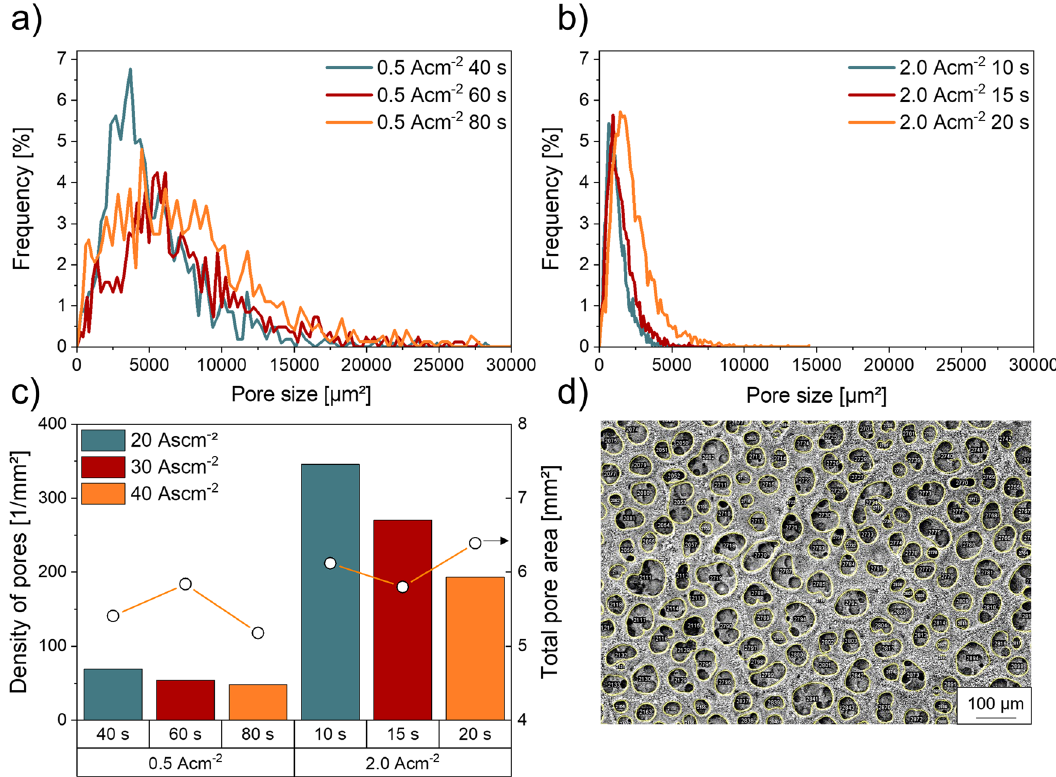
Fig. 5 In fl uence of the applied DHBT parameters on the pore size distribution, pore density and the size of the generated surface pores. a Pore size distribution of the tested samples with 2.0 Acm − 2 and b with 0.5 Acm − 2 at increasing deposition times, c pore density and total pore area of all tested samples, d one of 16 exemplary SEM images stitched together to a mosaic, taken for